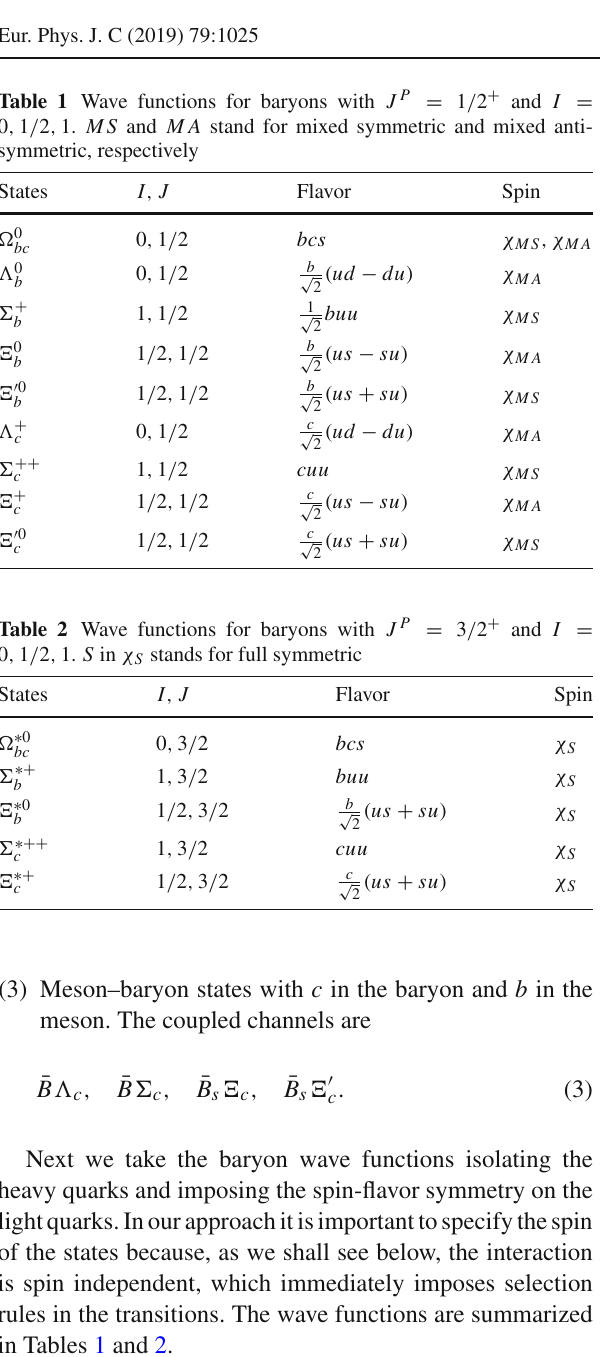
Table 1 Wave functions for baryons with J P = 1 / 2 + and I = 0 , 1 / 2 , 1. MS and M A stand for mixed symmetric and mixed anti- symmetric, respectively States